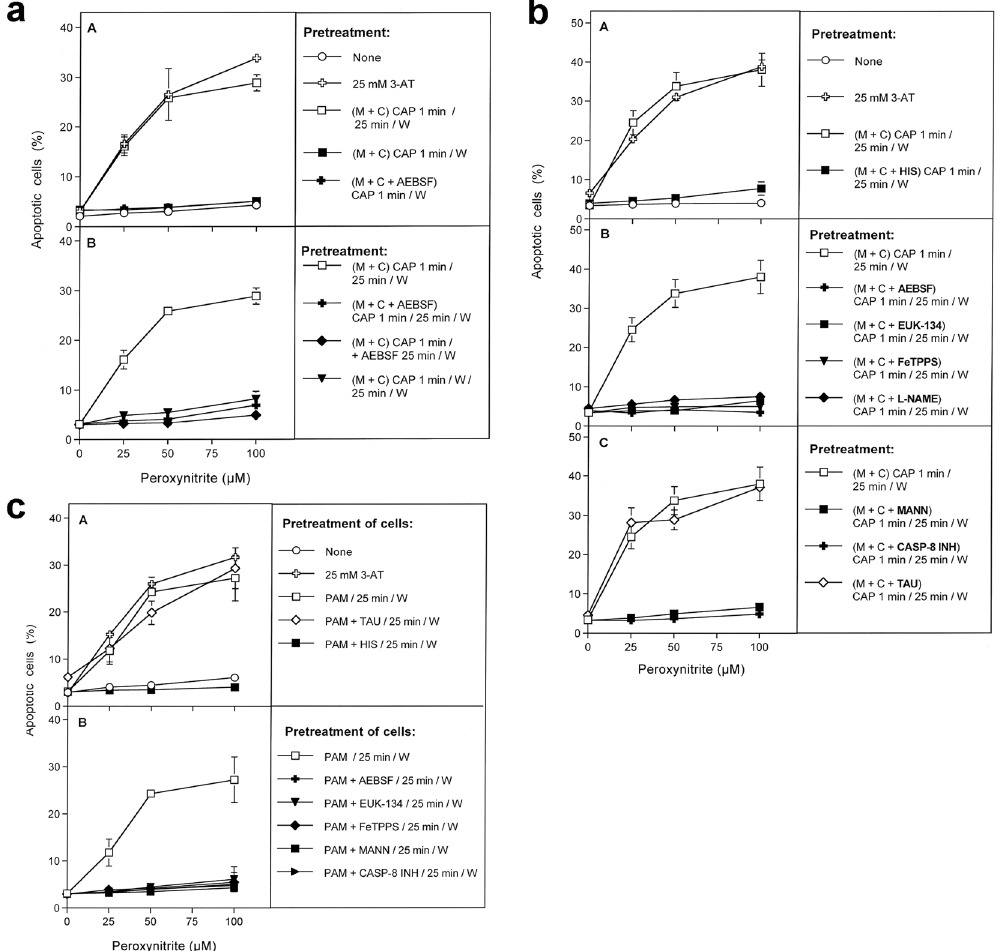
Figure 4. Inactivation of membrane-associated catalase of tumor cells by CAP and PAM. ( a ) Basic experiments. A. MKN-45 cells remained untreated (open circle) or were treated with 25 mM of the catalase inhibitor 3-AT (open cross), before they were challenged with peroxynitrite (ONOO − ) in the presence of the NOX1 inhibitor AEBSF (100 µ M). In parallel, cells were treated with CAP for 1 min, followed by 25 min in the same medium before they were washed (W), resuspended in fresh medium containing 100 µ M AEBSF, and were challenged with ONOO − (open square). Alternatively, cells in control medium (closed square) and cells in medium containing 100 µ M AEBSF (closed cross) were treated with CAP for 1 min, followed directly by a washing step (W) and immediate challenge with ONOO − in the presence of 100 µ M AEBSF. B. Cells in medium were treated with CAP for 1 min, followed by an incubation step of 25 min in the same medium, before the cells were washed (W) and resuspended in fresh medium (open square). This regime was modified by adding AEBSF (100 µ M) either before CAP treatment (closed cross) or at the beginning of the 25 min incubation (closed diamond), or by washing the cells immediately after the CAP treatment and incubating them for 25 min in fresh medium, followed by a second washing step (closed triangle). All assays were challenged with increasing concentrations of ONOO − , in the presence of 100 µ M AEBSF. The percentages of apoptotic cells were determined 2 h after addition of ONOO − . The results show that catalase inhibition by 3-AT or treatment of the cells with CAP for 1 min, followed by 25 min of incubation in the same medium caused sensitization towards ONOO − , indicative for catalase inactivation. Catalase inactivation through CAP treatment required that the long-lived species generated by CAP need to interact with the tumor cells during the 25 min incubation step and that NOX1 was not inhibited during this incubation step. Statistical analysis: Apoptosis induction by all concentrations of ONOO − , in the presence of 3-AT or after pretreatment with CAP is highly significant (p < 0.001). The inhibitory effect of AEBSF is highly significant (p < 0.001). ( b ) Elucidation of the biochemical mechanism of CAP-mediated inactivation of catalase. (A) MKN-45 cells were not pretreated or treated with 25 mM of the catalase inhibitor 3-aminotriazole (3-AT), received 100 µ M of the NOX1 inhibitor AEBSF and were then challenged by increasing concentrations of peroxynitrite (ONOO − ). The percentages of apoptotic cells were determined 2 h after the ONOO − challenge. In parallel, MKN-45 cells were treated with CAP for 1 min, followed by 25 min incubation in the same medium and three cycles of washing (W) (“(M + C) CAP 1 min/25 min/W”). In addition, the same regime was performed in the presence of the 1 O 2 scavenger histidine (HIS) during CAP treatment and the 25 min incubation step (“(M + C + HIS) CAP 1 min/25 min/W”) 100 µ M AEBSF were then added and the cells were challenged with increasing concentrations of ONOO − . The percentages of